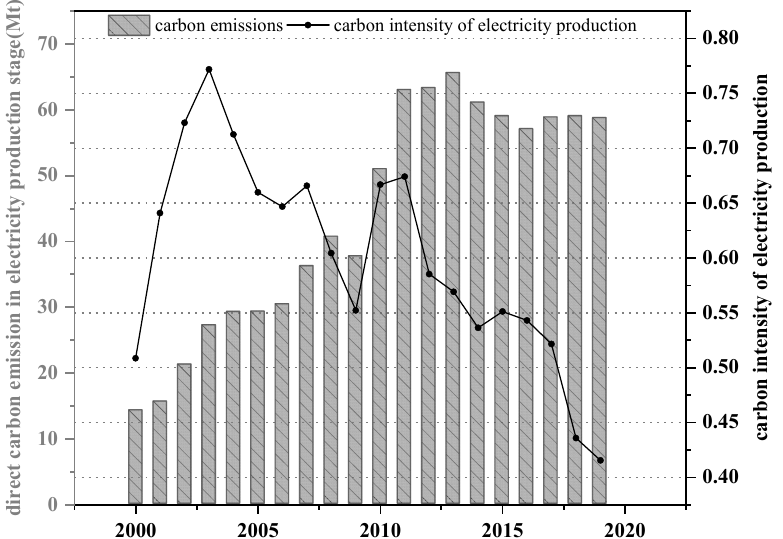
Figure 5. Carbon emissions from power production and carbon emission intensity in Gansu Province during 2000–2019.